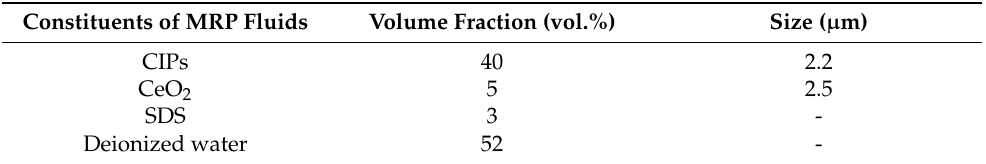
Table 3. Proportion and particles size of the MRP fluids.